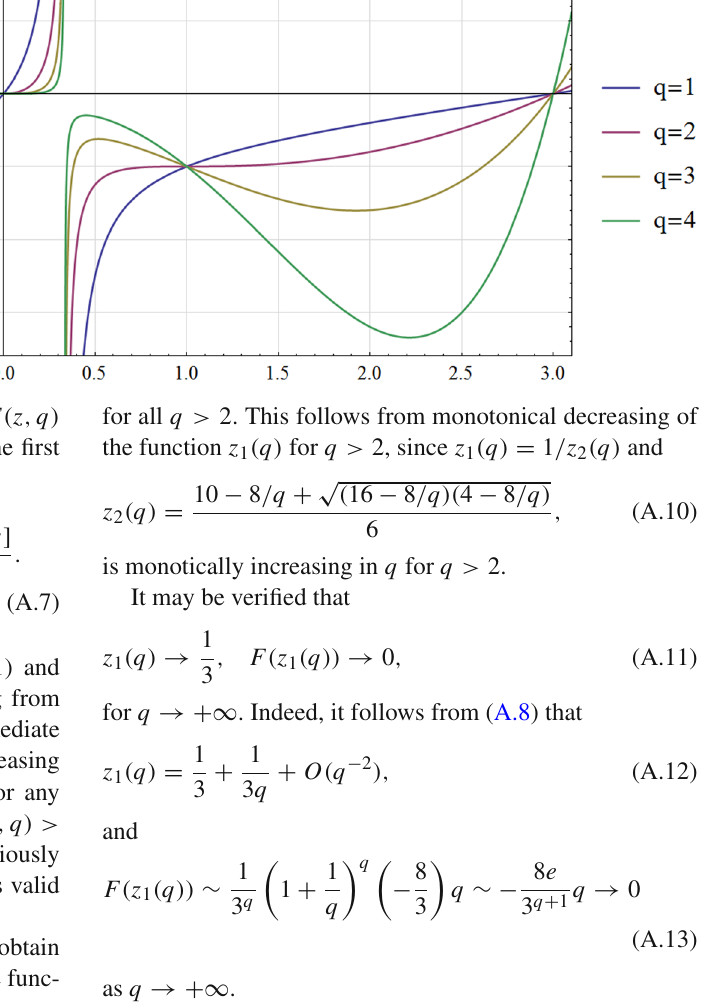
Fig. 6 The graphical representation of the functions F ( z ) = F ( z , q ) for q = 1 , 2 , 3 ,